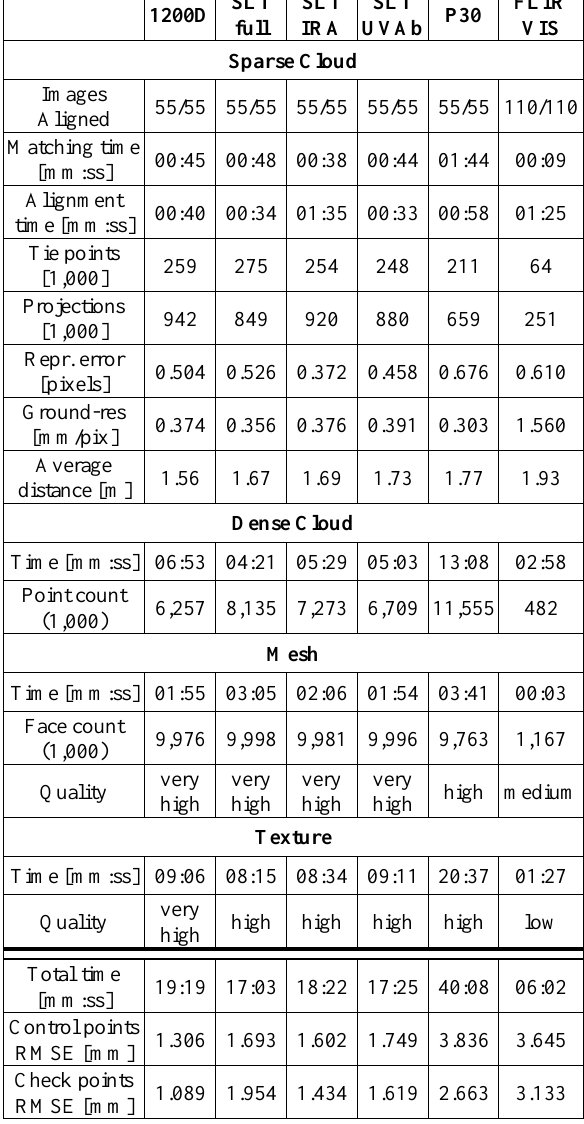
Table 10: Agisoft Metashape results